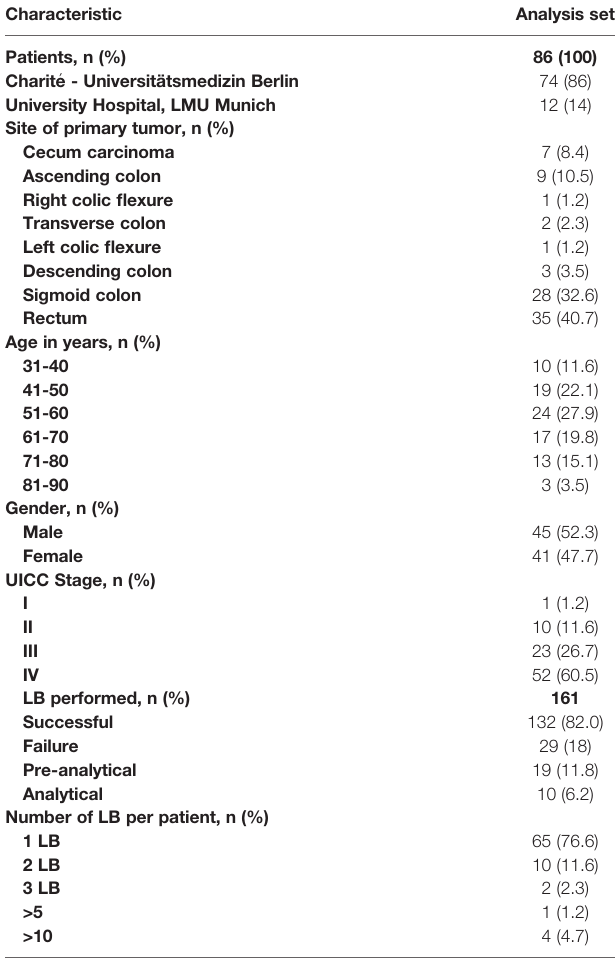
TABLE 1 | Baseline characteristics of ctDNA analysis cohort of CRC